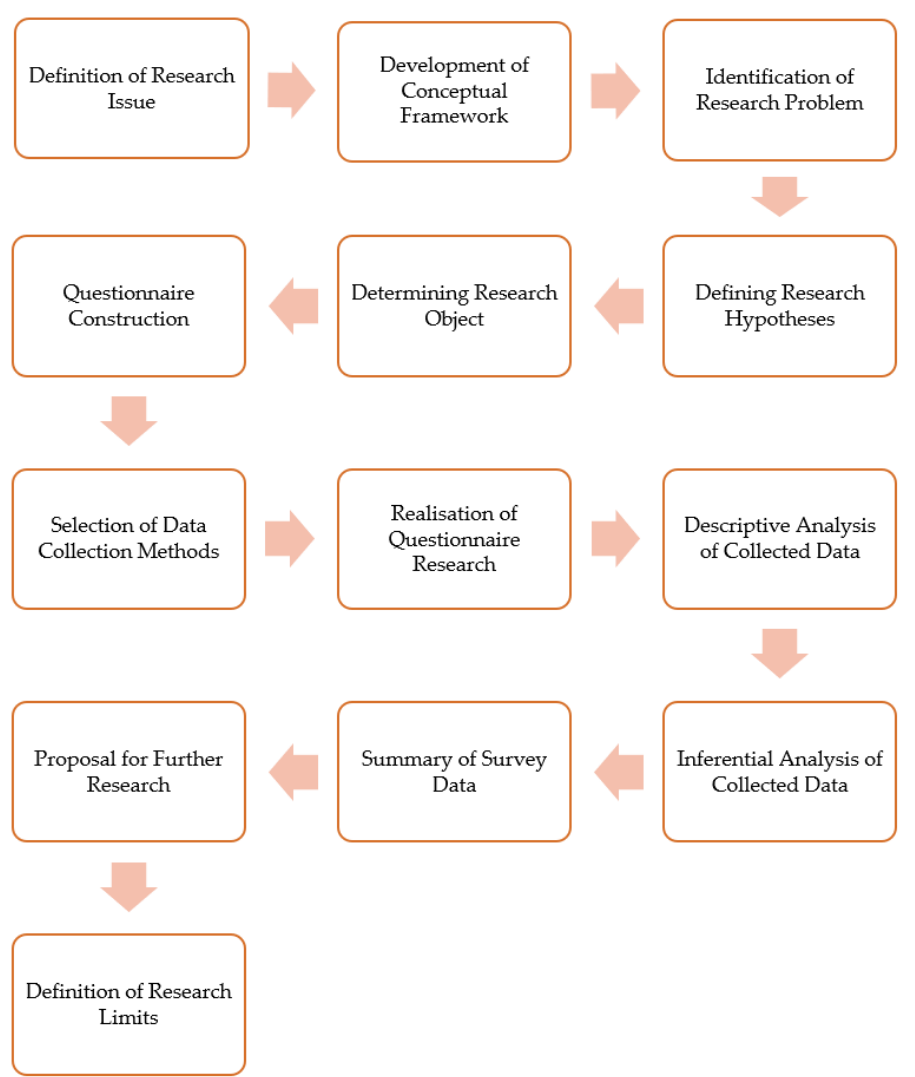
Figure 1. Visualisation of research methodology.